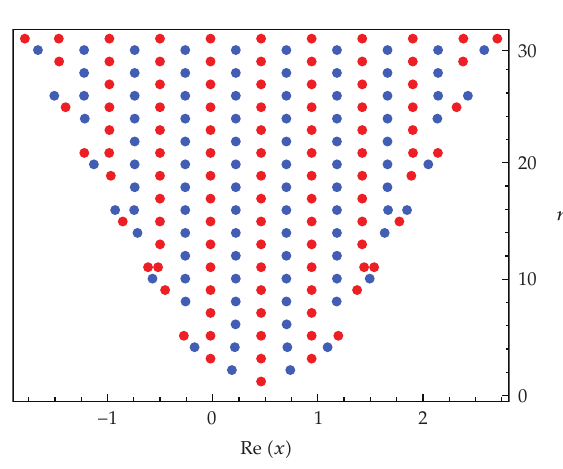
Figure 8: Real of zeros of B n (cid:2) x (cid:3) , 1 ≤ n ≤